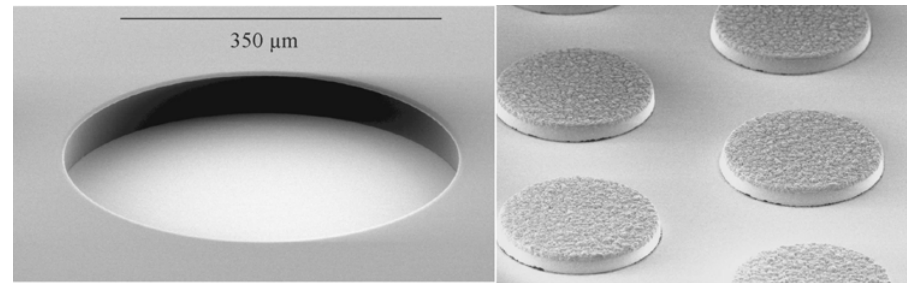
Figure 1. Principle sketch of the first processing steps: heat-sink definition and gold plating.